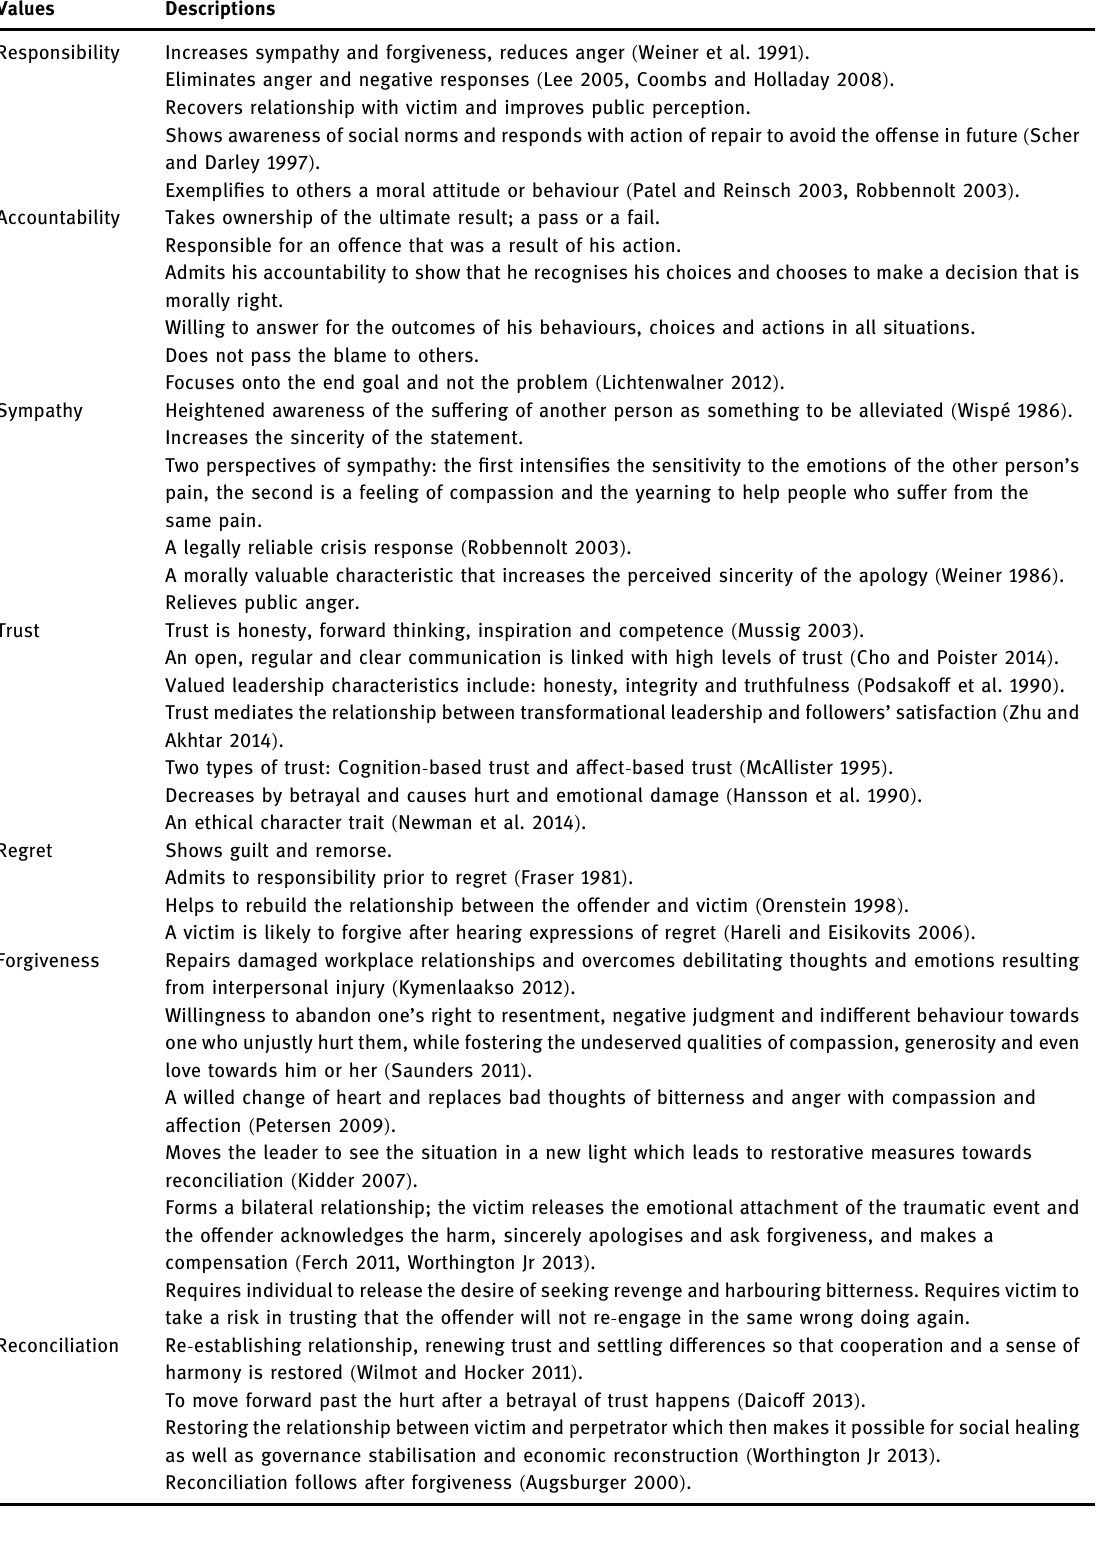
Table 3: Leadership values